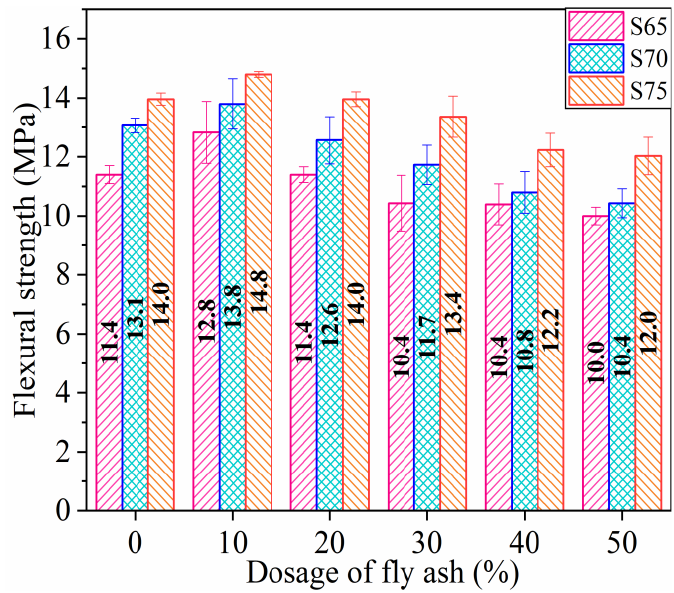
Figure 5. Flexural strength of